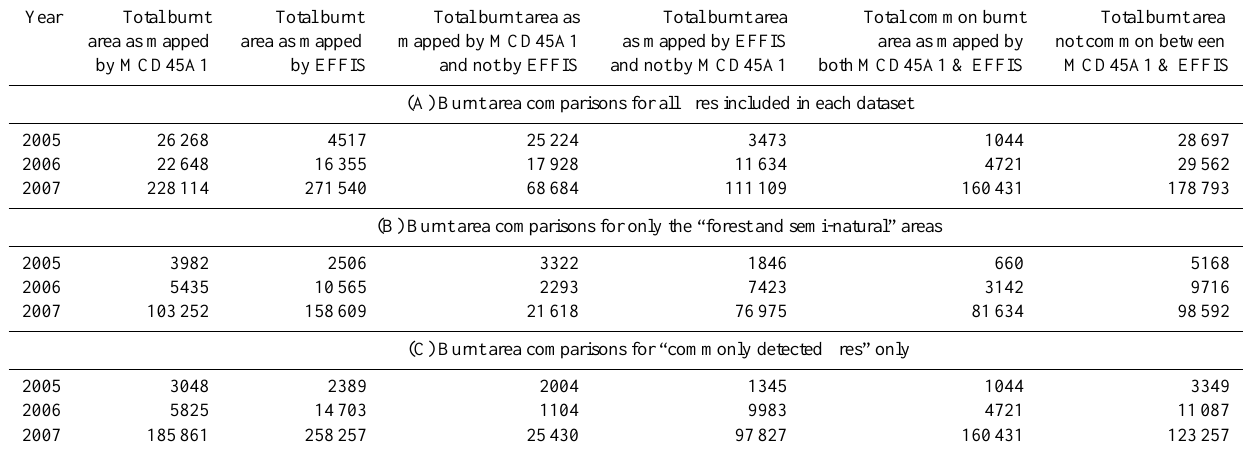
Table 1. Summarised statistics of the burnt area estimates between the two products for the years 2005–2007. Burnt area is expressed in ha. Year Total burnt Total burnt Total burnt area as Total burnt area Total common burnt Total burnt area area as mapped area as mapped mapped by MCD45A1 as mapped by EFFIS area as mapped by not common between by MCD45A1 by EFFIS and not by EFFIS and not by MCD45A1 both MCD45A1 & EFFIS MCD45A1 &